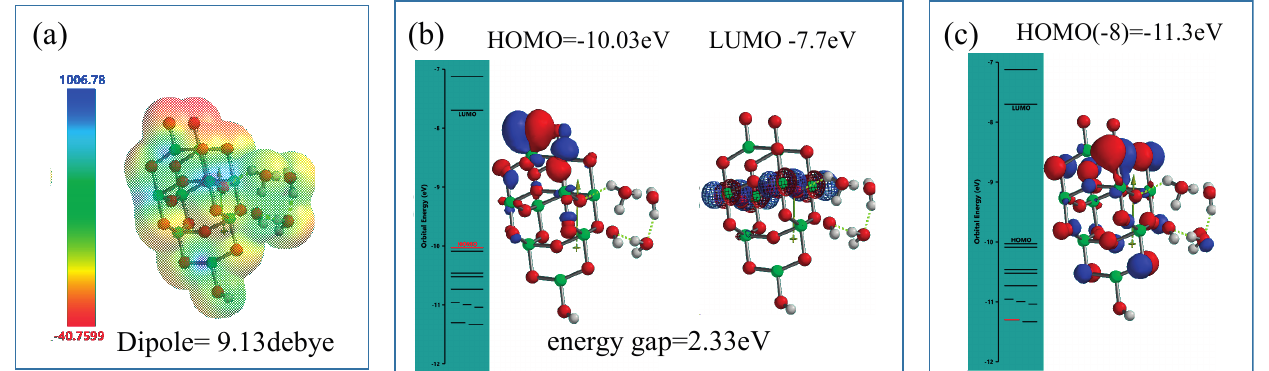
Figure 8. DFT-simulation of H 3 O + (H 2 O) 2 &OH(TiO 2 ) 9 H as a model of hydronium ion clusters on PEC-nc-TiO 2 electrodes, ( a ) electrostatic potential map; ( b ) structures of HOMO and LUMO; ( c ) Configuration of HOMO( −